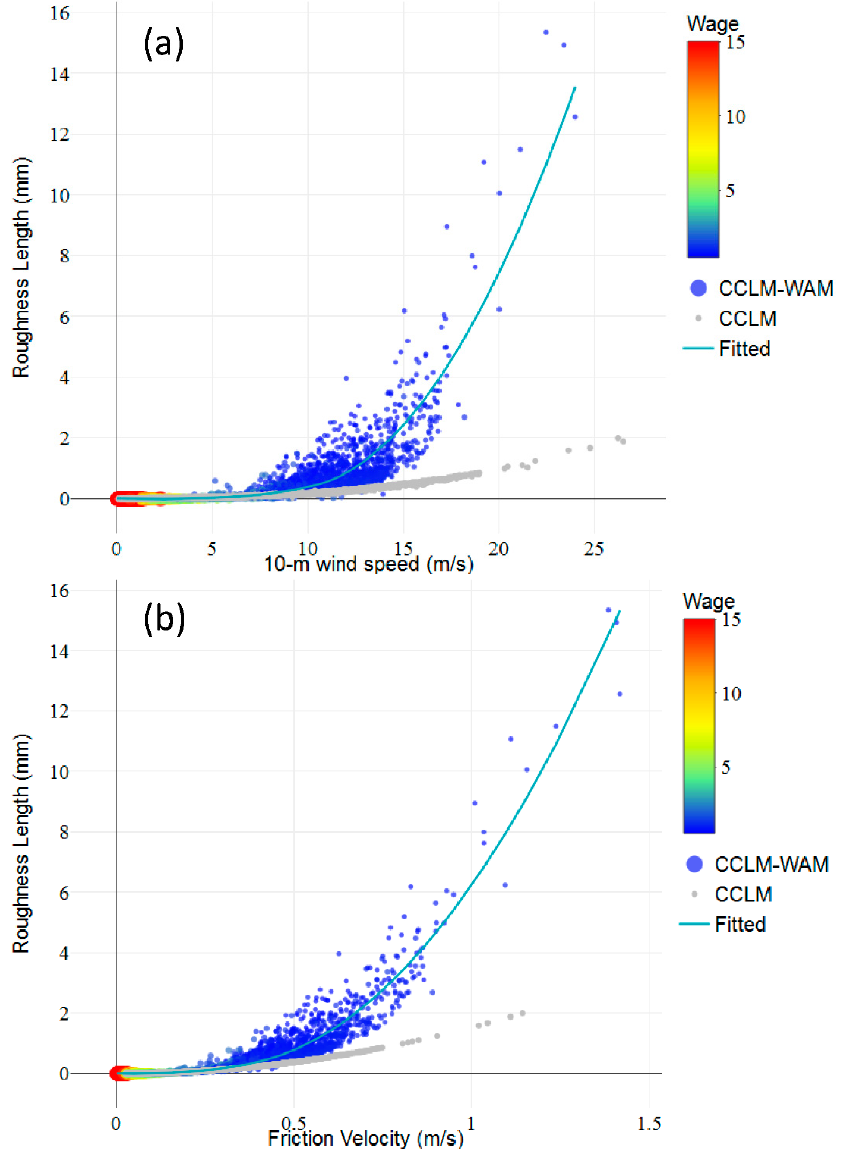
Figure 12. Relationship between ( a ) 10-m wind speed and roughness length, ( b ) friction velocity and roughness length at station IEODO for the year 2010. Colored points indicate the CCLM-WAM simulation, while grey points indicate the CCLM standalone simulation. The lines indicate the polynomial regression fitting lines for coupled simulations.